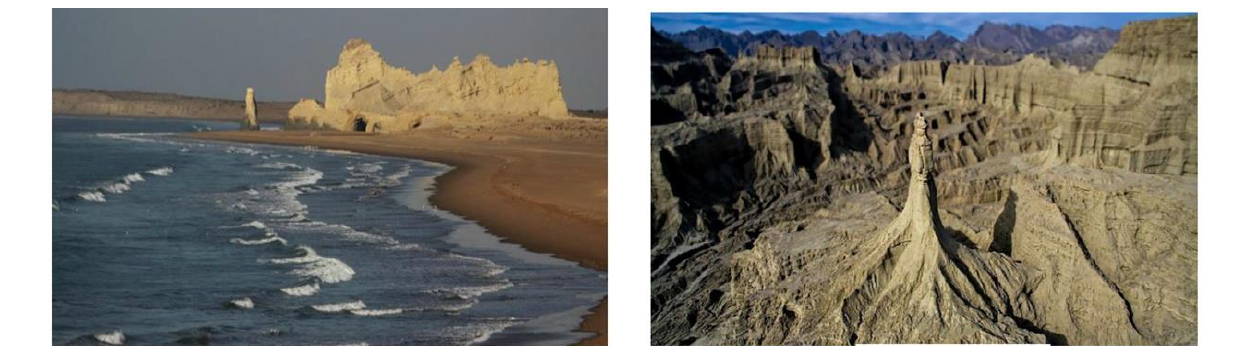
Fig. 1. Hingol National Park – location and cover land